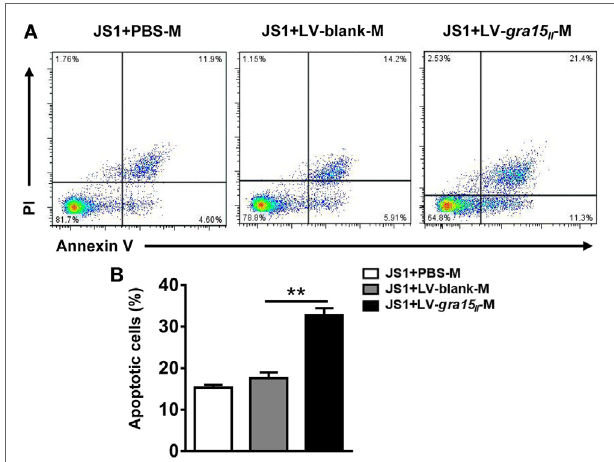
FigUre 7 | Lentiviral vector- gra15 II -M promoted hepatic stellate cell apoptosis. Liver macrophages were co-cultured with JS1 cells for 48 h in transwell, and then JS1 cells were collected and assessed for apoptosis by FCM (a,B) . Data represent mean ± SD from multi-group experiments. ** p < 0.01 ( n = 4 each